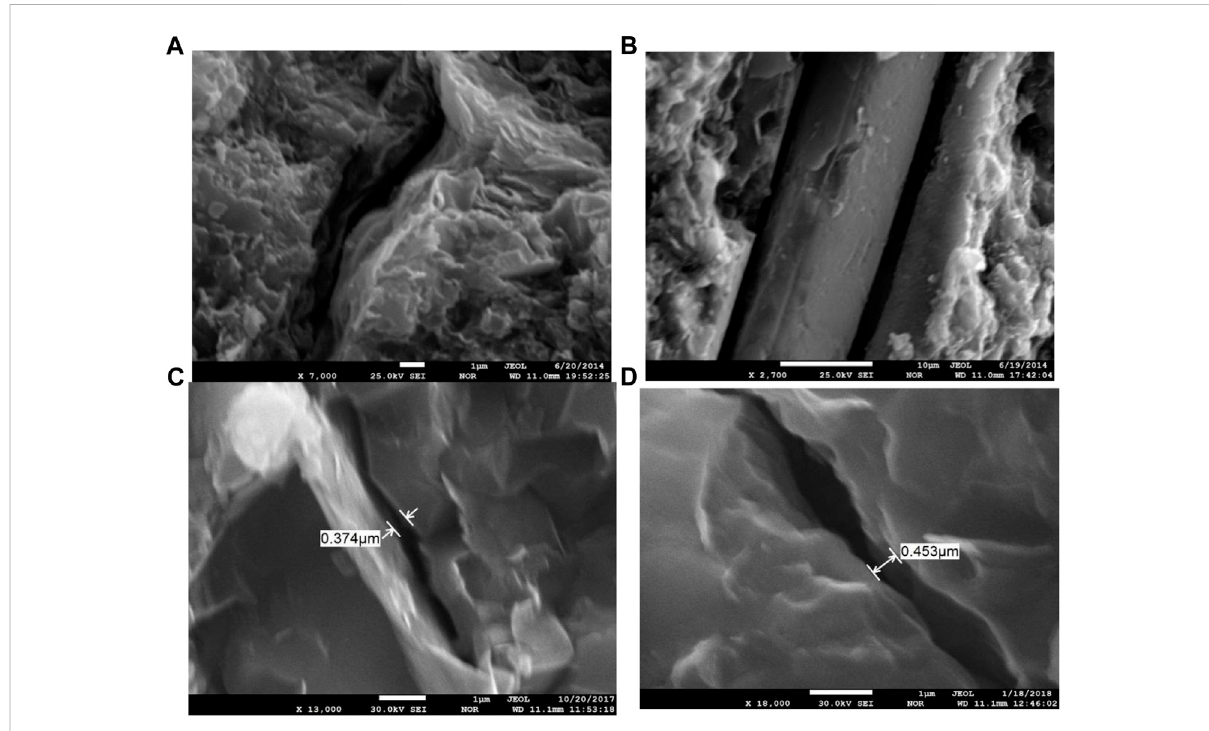
FIGURE 10 Fracture type of all samples: (A) dissolution fi ssure in the upper section; (B) straight gap between mineral particles of sandstone in the lower section; (C) micro-fracture of sandstone in the upper section; (D) micro-fracture of sandstone in the upper section.